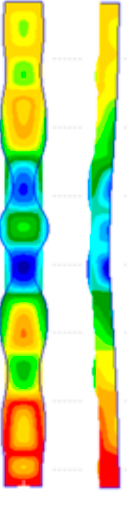
Figure 17. Deformation plots at location A.